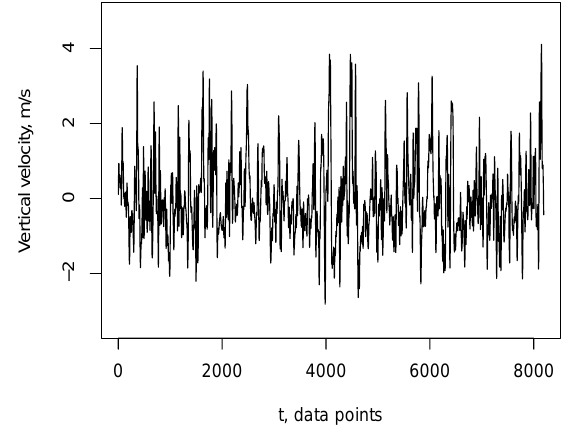
Fig. 2. Record of 20-Hz aircraft vertical velocity measurements over Lake